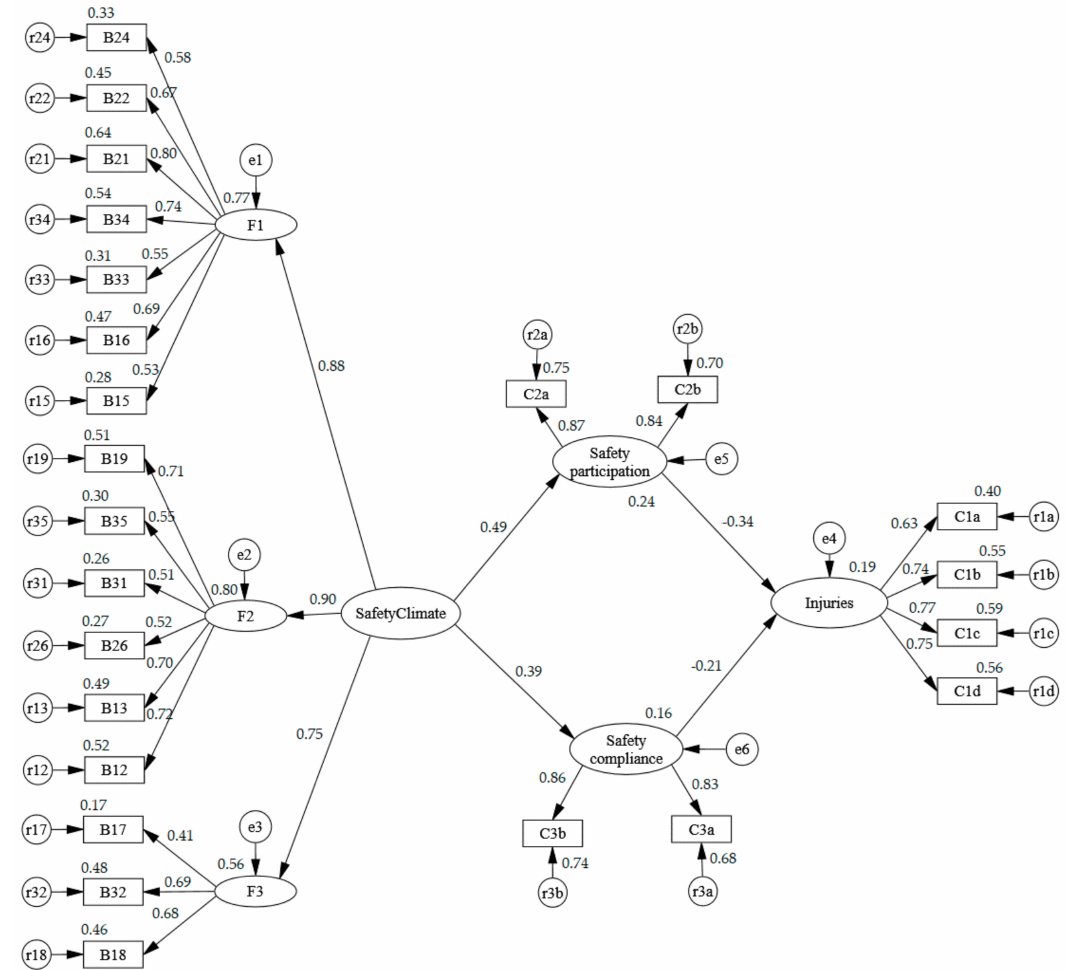
Figure 2. Structural equation model on ethnic minorities (EMs) with standardized path coefficients. Note: the description of each code in this figure is shown in Appendix